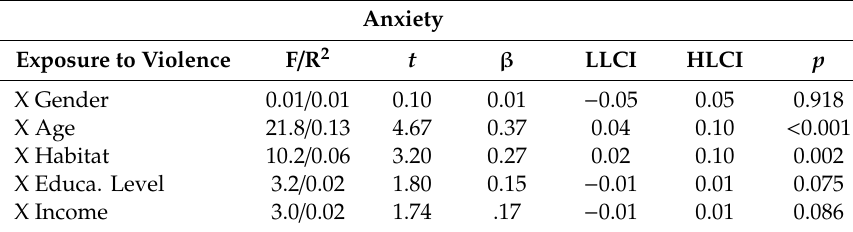
Table 8. Moderation analyses for anxiety.